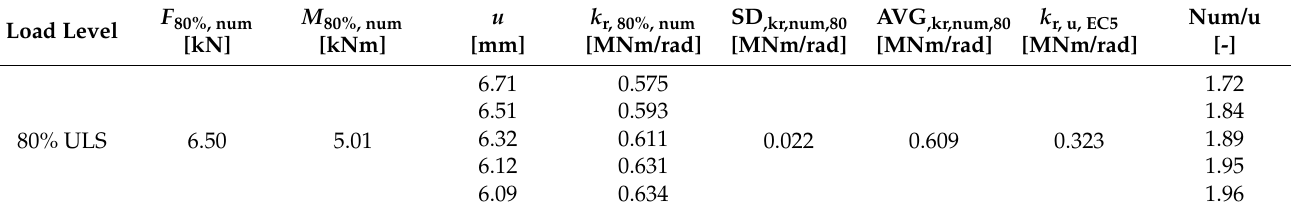
Table 13. Results of quasi ‐ static cyclic numerical modeling for Experiment A at 80% ULS.